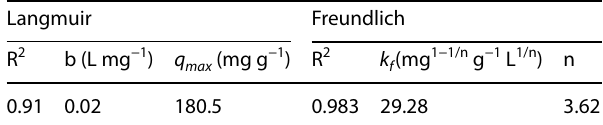
Table 2 Langmuir and Freundlich isotherm parameters